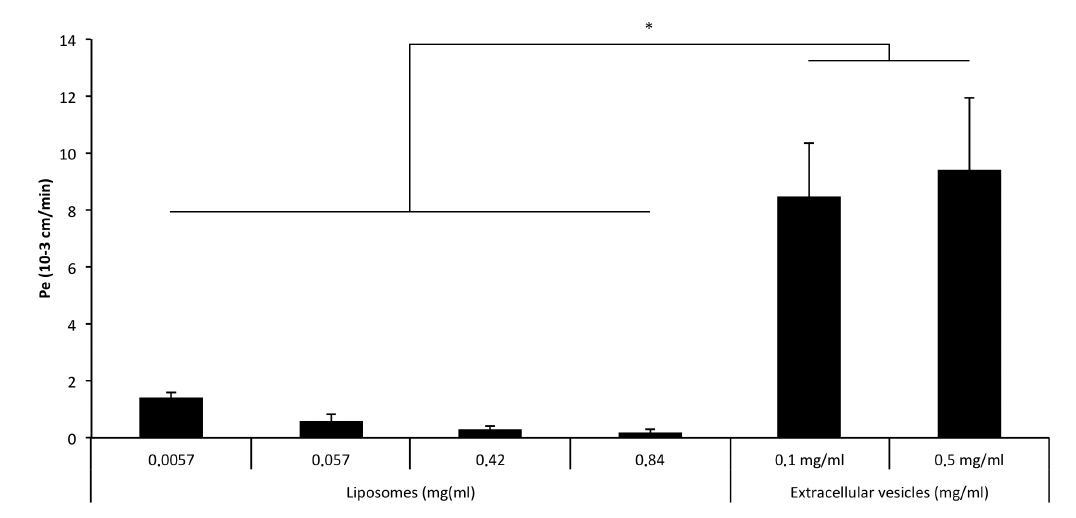
Figure4. Transendothelialmigrationofliposomesandexosomes: Permeabilityofendothelialmonolayer for liposomes and extracellular vesicles. Polymeric nanoparticles were not able to cross the blood–brain barrier (BBB) and are not, therefore, shown in the figure. EVs showed the highest levels of permeability, indicating that could be a proper candidate for microRNA delivery to the central nervous system (CNS). (*) p < 0.005 with respect to Liposomes